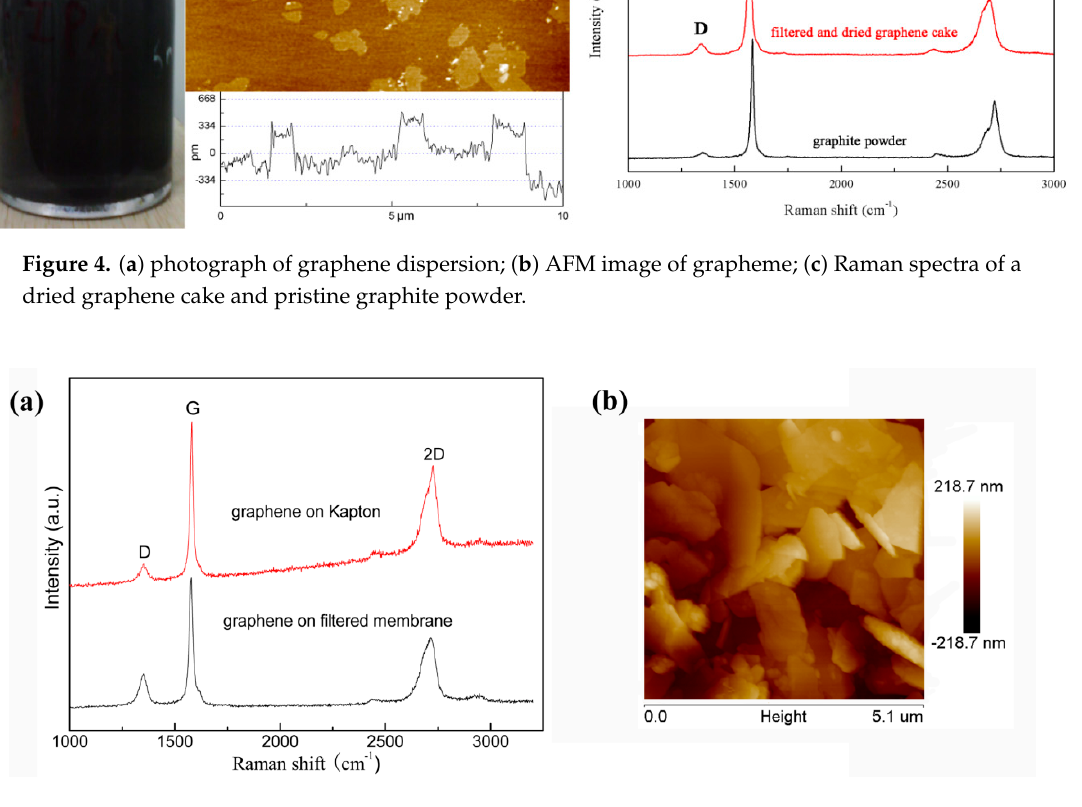
Figure 5. ( a ) Raman spectra of graphene on filtered membrane and graphene on Kapton; ( b ) AFM of graphene coating on Kapton.